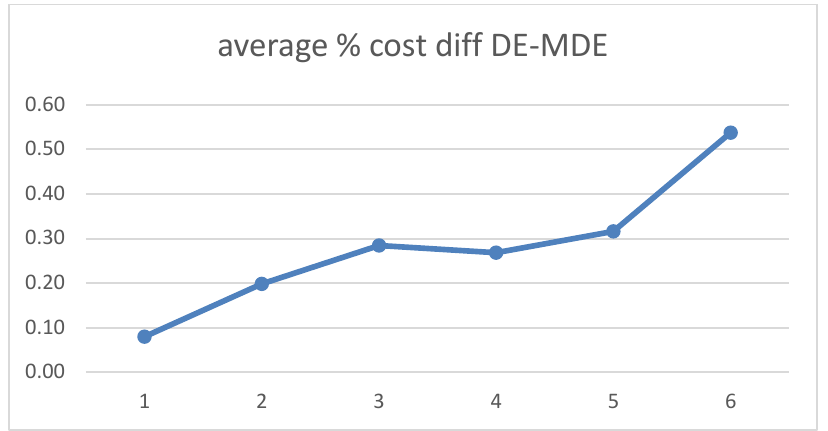
Figure 4. Average percent difference between DE and MDE. 1, 2, 3, 4, 5, and 6 represent computational times of 10, 30, 40, 60, 80, and 60 min, respectively.